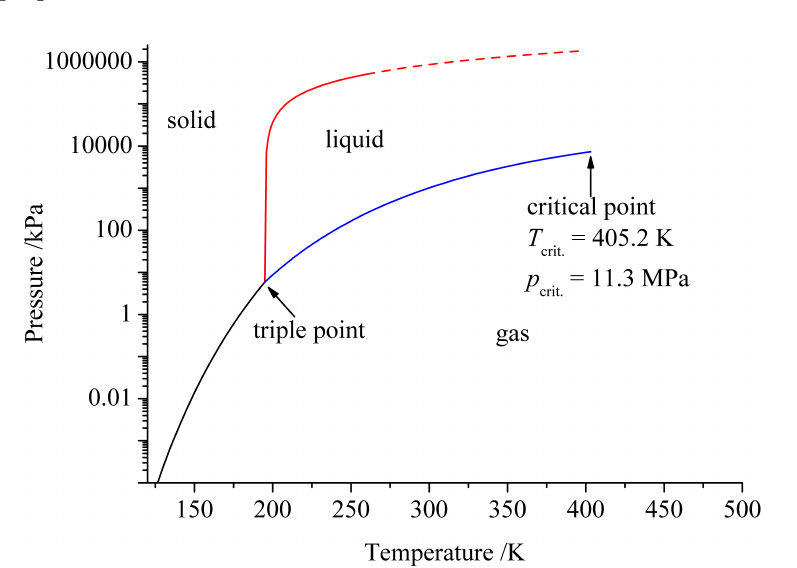
Figure 1. Pressure-temperature phase diagram of ammonia. The dashed line is extrapolated [58].